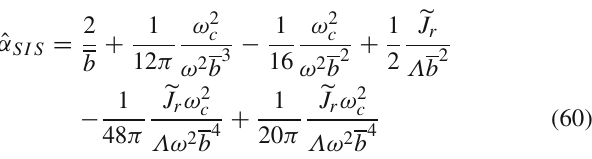
Fig. 5 Plot of ˆ α SIS vs. b / 2 M for Λ = 1 (continuous line), Λ = 0 . 2 (dashed line), and Λ = 0 . 1 (dot-dashed line). We used J r / M 2 = 0 . 25, sin χ = 1, and ω 2 c /ω 2 = 0 . 5